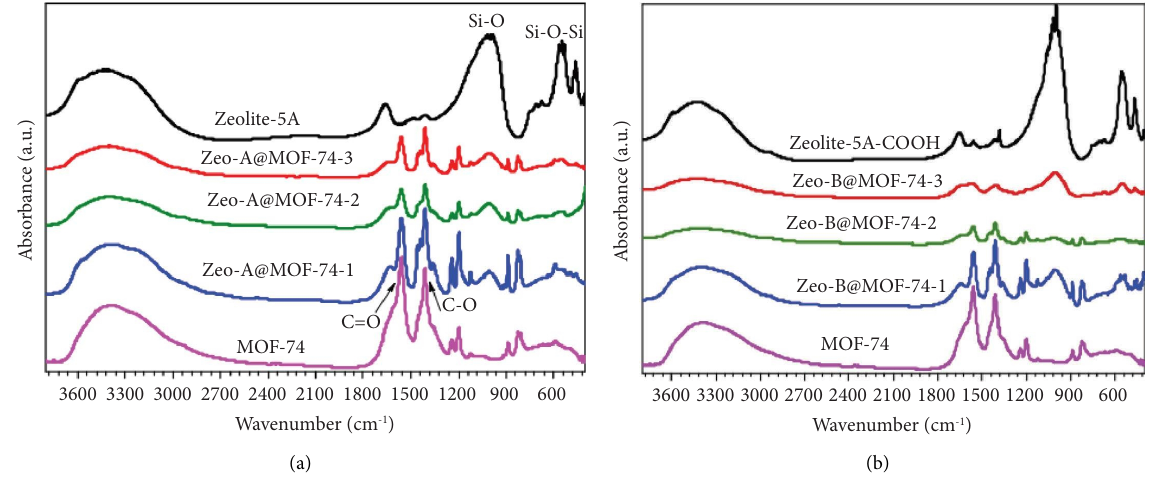
Figure 20: (a) FTIR spectra for a zeolite-5A and (b) zeolite-5A-COOH based composites adopted from